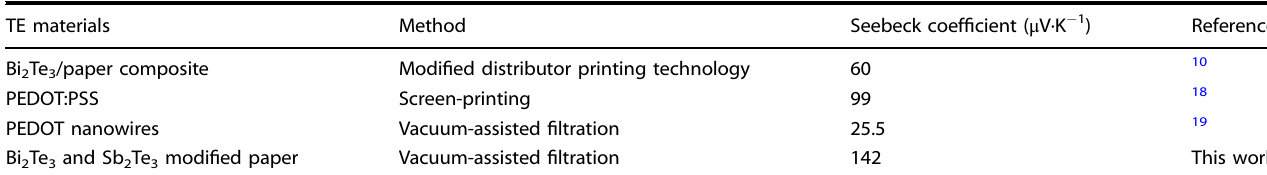
Table 1. Comparison of the reported Seebeck coef fi cient of a single leg of the fl exible TE devices at room temperature. TE